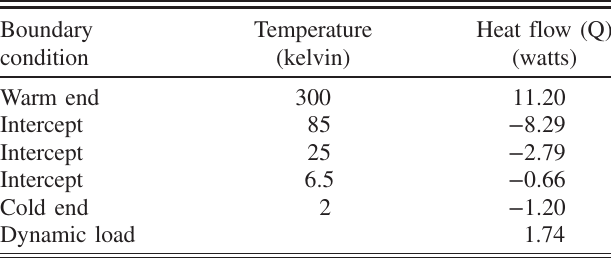
TABLE II. Dynamic heat